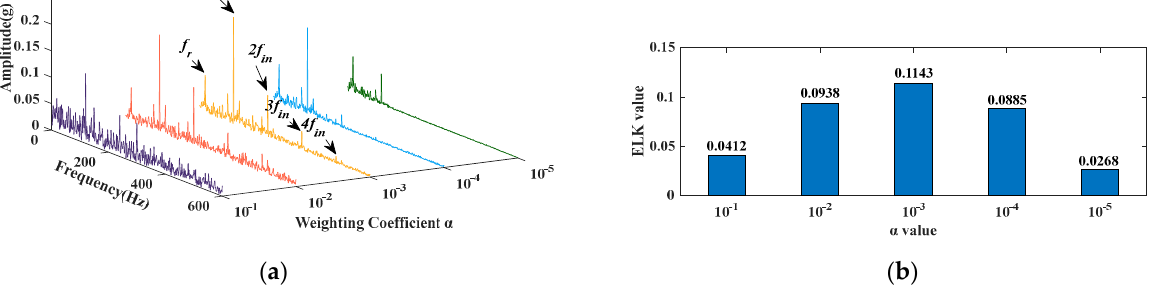
Figure 5. Filtering signals by ACMD with different α : ( a ) envelope spectrums; ( b ) ELK value.